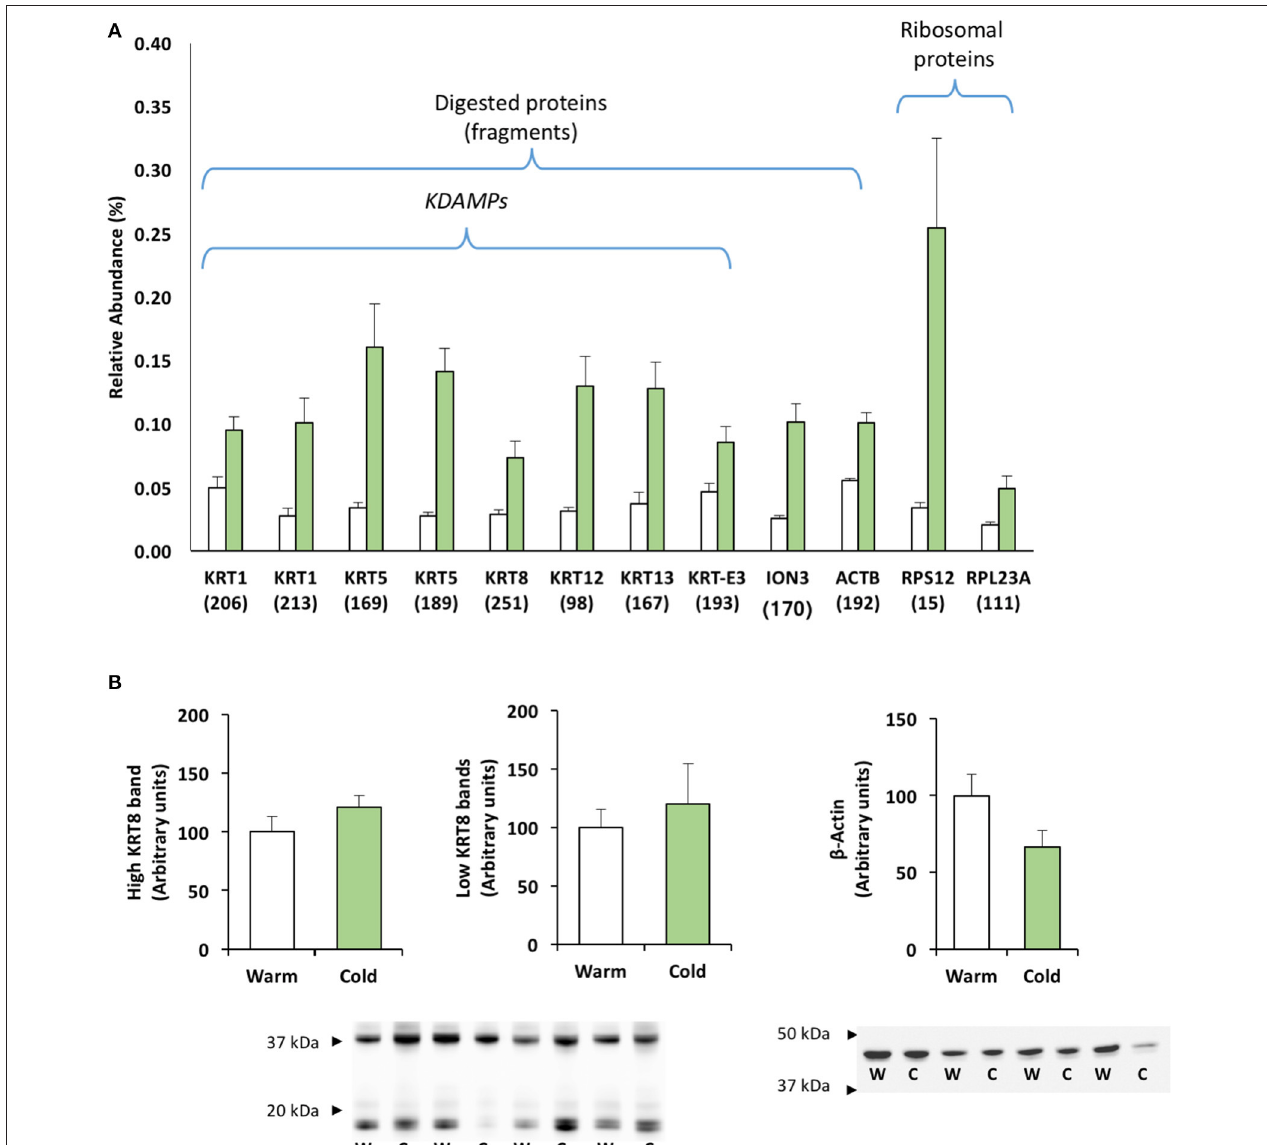
FIGURE 3 | Relative expression of identified protein fragments with putative antimicrobial activity. (A) Histogram of protein abundance. Values corresponded to mean ± S.E.M. of the relative abundance of differentially expressed proteins. The digested proteins corresponded to proteins identified with observed MW lower than theoretical MW (see details in Table 1 ). Over-expressed ribosomal proteins are shown due to their antimicrobial activity. (B) Cytokeratin-8 (KRT8) and β -actin relative abundances by Western blot